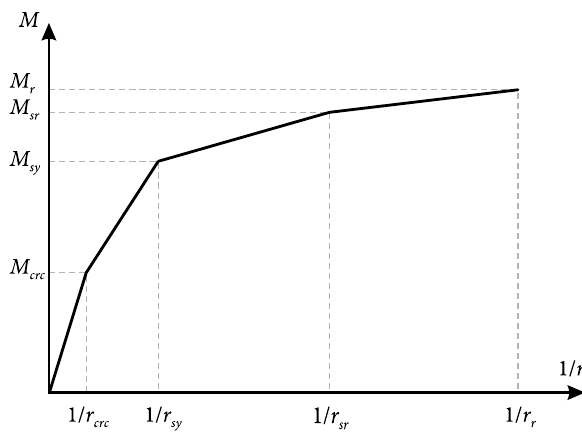
Fig. 2. Bending moment–curvature relationship for